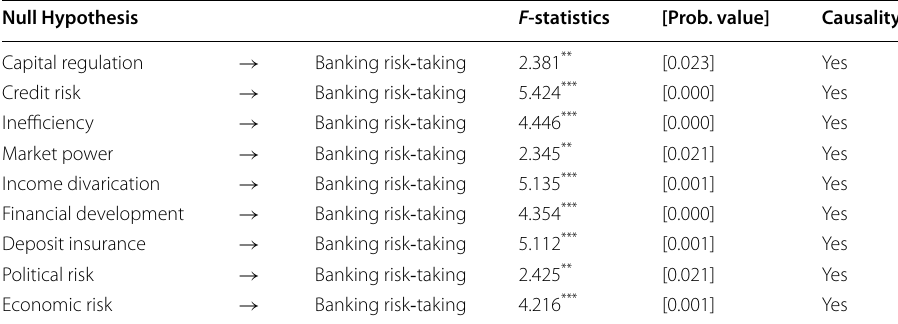
The symbols *, ** and *** indicate statistical significance at the 10%, 5% and 1% levels,